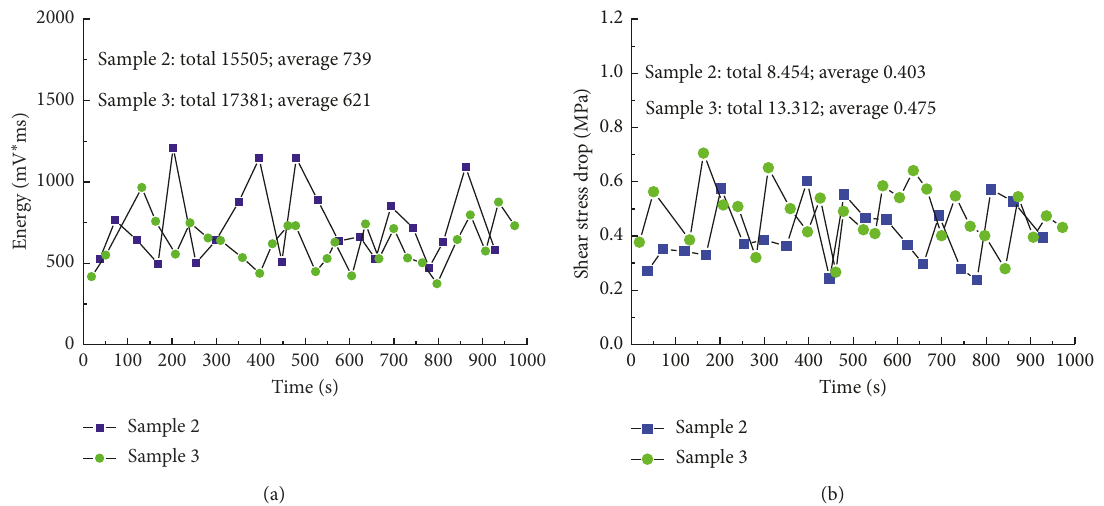
Figure 7: Comparison of AE energy and shear stress drop during the statistical stick-slip periods of Samples 2 and 3. (a) AE energy. (b) Shear stress